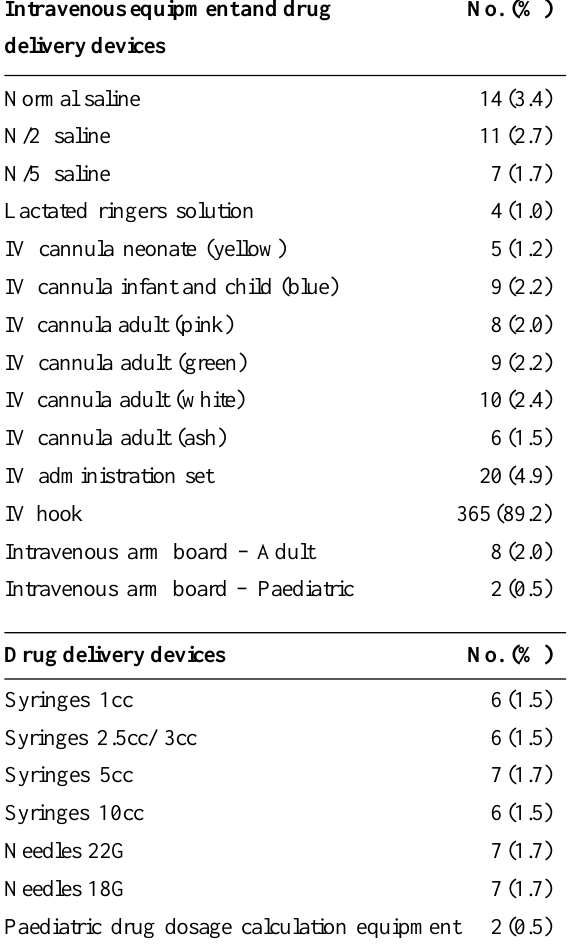
Table 7. Intravenous equipment and drug delivery devices available for an advanced life support (ALS) ambulance